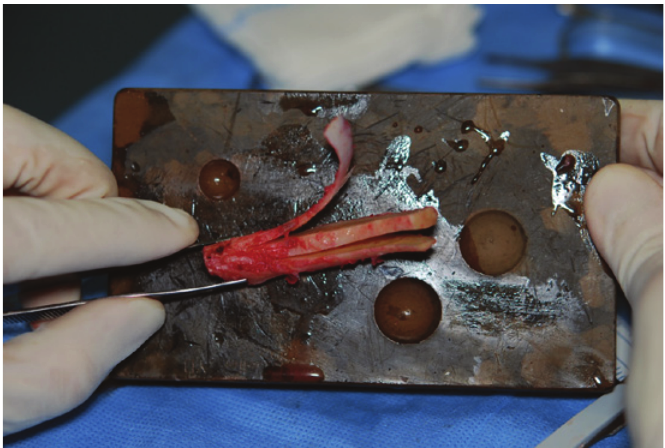
FIGURE 2 - Rib carving technique used only the central aspect of the cartilage because it’s straighter.